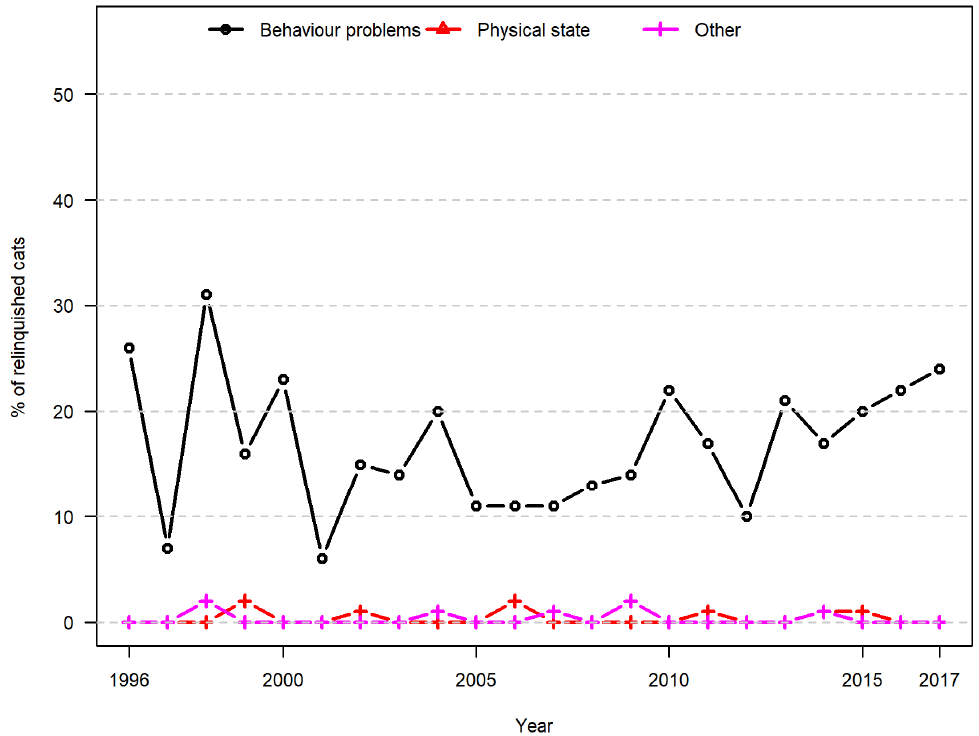
Figure 7. Animal-related reasons for relinquishment (cats). Proportional distribution of reported animal-related reasons for the relinquishment of cats in a Danish animal shelter from 1996 to